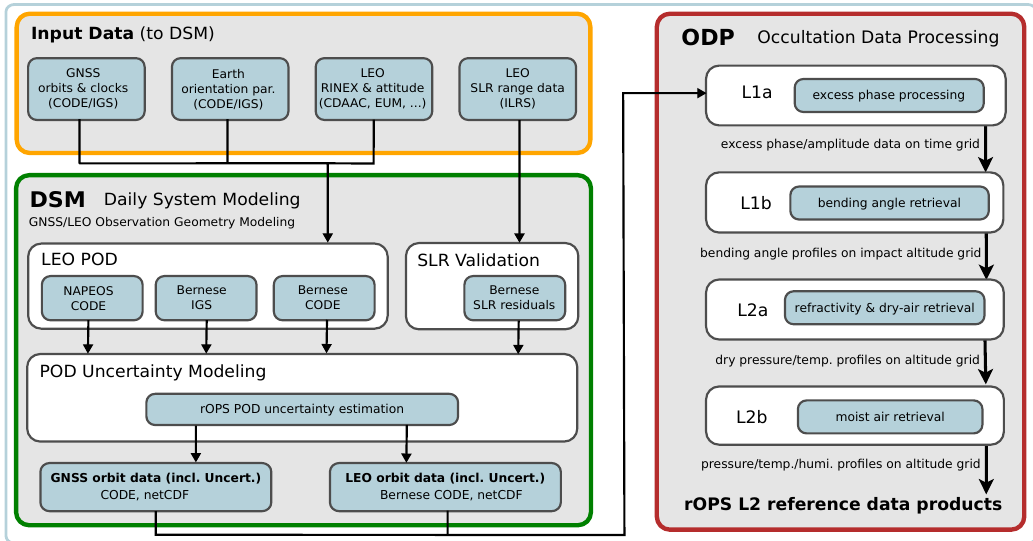
Figure 1. Schematic overview of parts of Wegener Center for Climate and Global Change (WEGC)’s Reference Occultation Processing System (rOPS) relevant to this study, comprising the input data for the precise orbit determination (Input Data; orange box), the daily system modeling (DSM; green box), and the occultation data processing (ODP; red box). For spelling of institution acronyms (in Input Data and DSM boxes) and further description see Section 3. The ODP box outlines the main level 1 and level 2 retrieval steps (L1a to L2b) from excess phase to essential climate variables